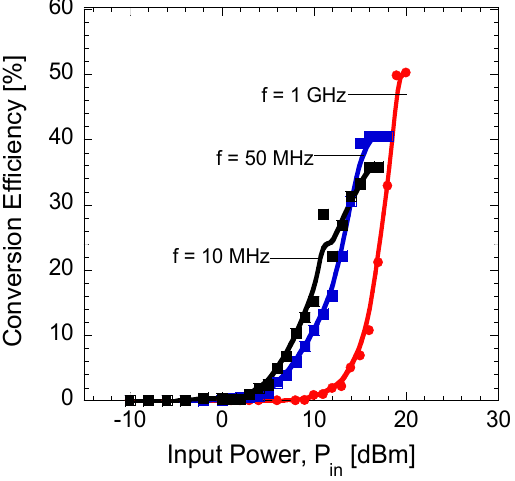
Figure 7. Conversion efficiency as a function of input power at frequency of 10 MHz, 50 MHz and 1 GHz.